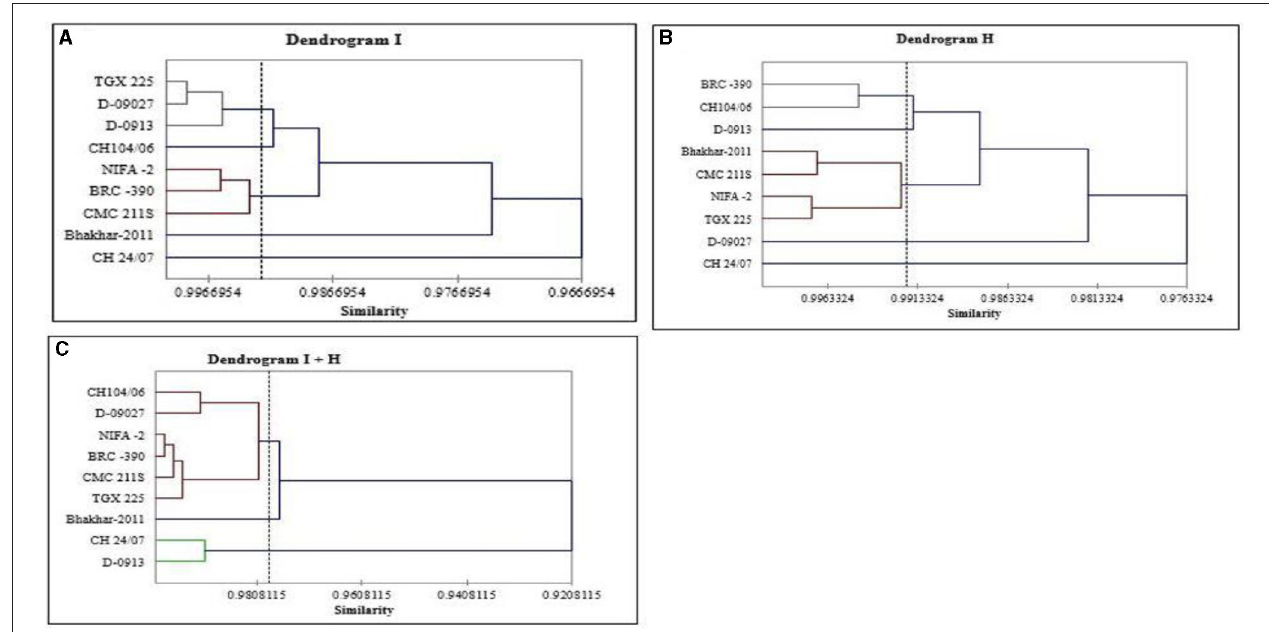
FIGURE 3 | Tree diagram based on morphophysiological and biochemical traits for different chickpea genotypes under (A) irrigation, (B) heat, and (C) combined stress conditions.